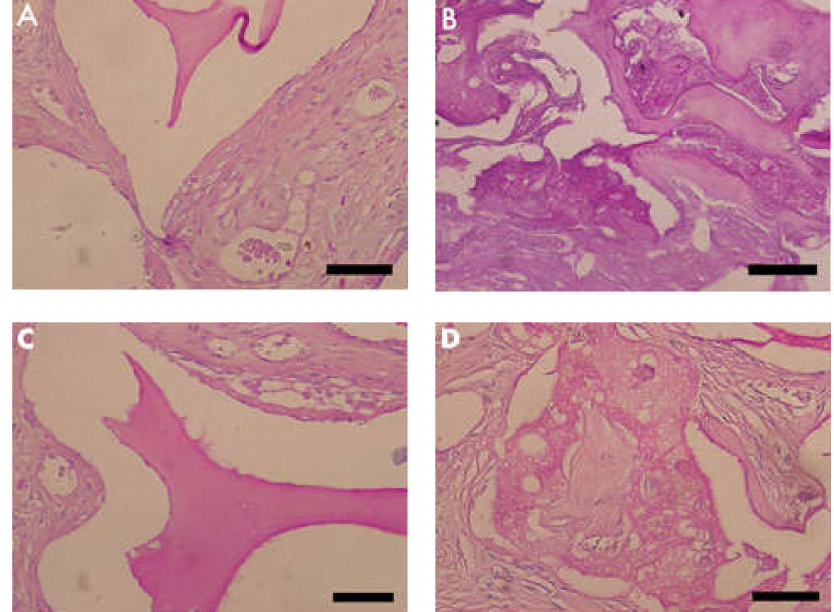
Figure 5. Photomicrographs of periodic acid–Schi ff (PAS)-stained slides. The pink color indicates precursors of the bone matrix. ( A,C ) Group 1 (bone xenograft), ( B,D ) Group 2